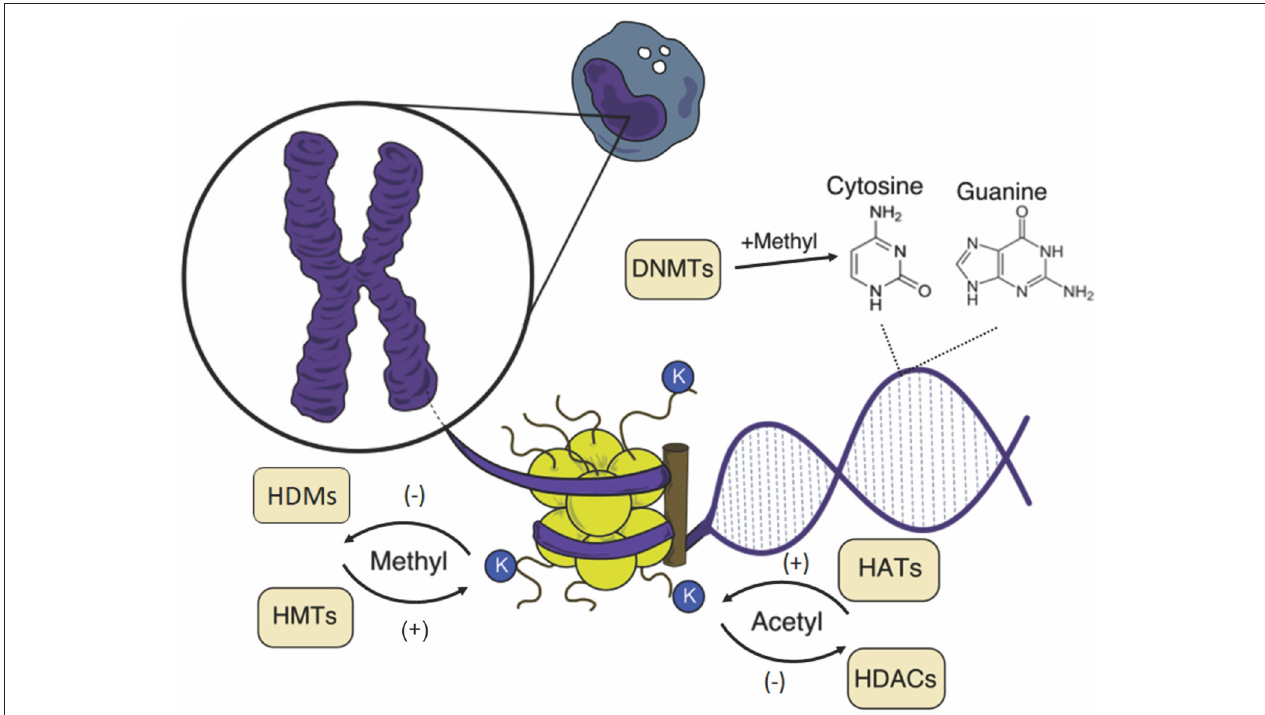
FIGURE 1 | Schematic representation of epigenetic changes in the mononuclear cell. The chromosome is composed of chromatin, a complex formed by DNA and nucleosomes, and the core is formed by an octamer of histones. Both DNA and histones can suffer the action of catalyzing enzymes of chemical groups that influence the chromatin structure, affecting gene expression. K, lysine; HATs, histone acetyltransferases; HDACs, histone deacetylases; HMTs, histone methyltransferases; HDMs, histone demethylases; DNMTs, DNA